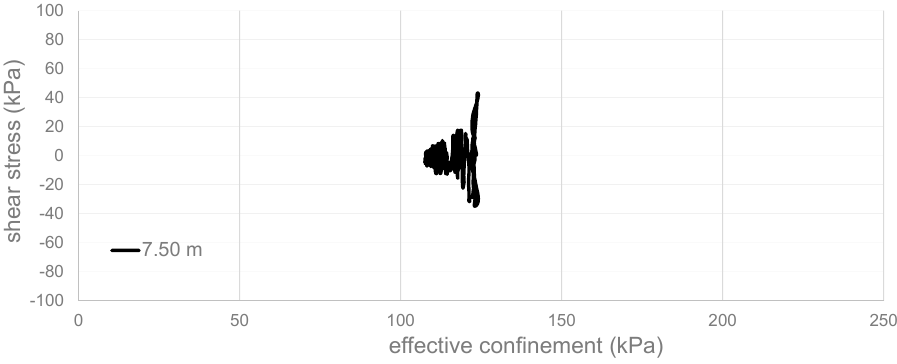
Figure 9. Model-10 m: effective confinement vs. shear stress at 7.50 m depth.